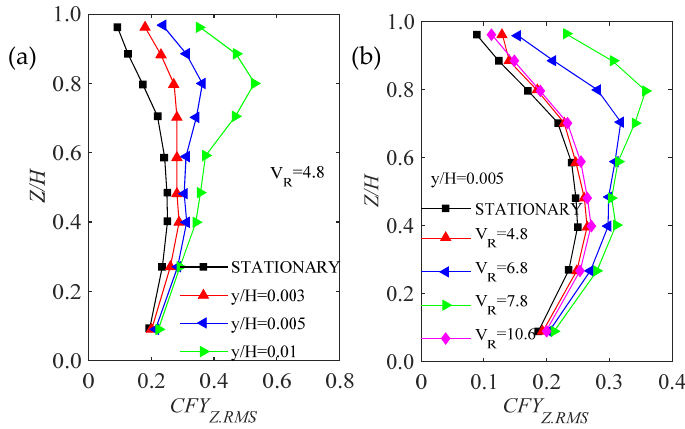
Figure 11. The effect of oscillating amplitude and reduced velocity on the sectional crosswind force coefficients, after [30]: ( a ) with respect to tip amplitude of the bluff body; ( b ) with respect to the reduced wind speed.